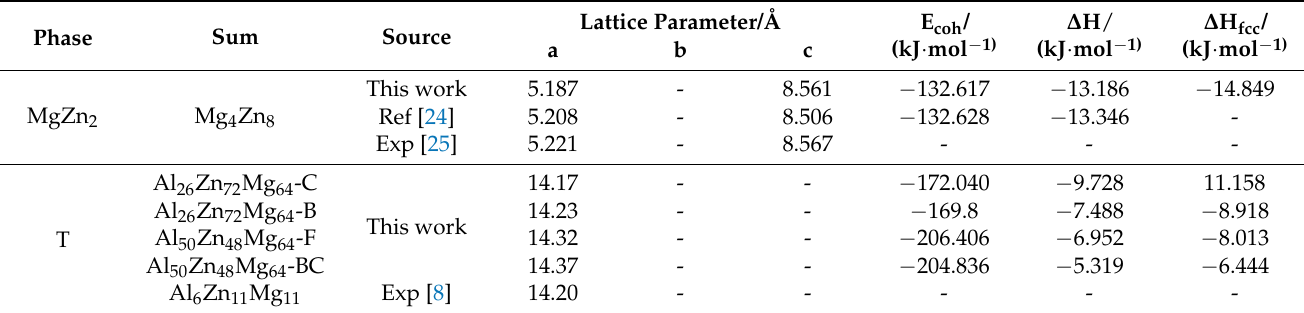
Table 2. Lattice parameters, cohesive energy E coh , and formation enthalpy ∆ H of the phases T-phase, MgZn 2 .